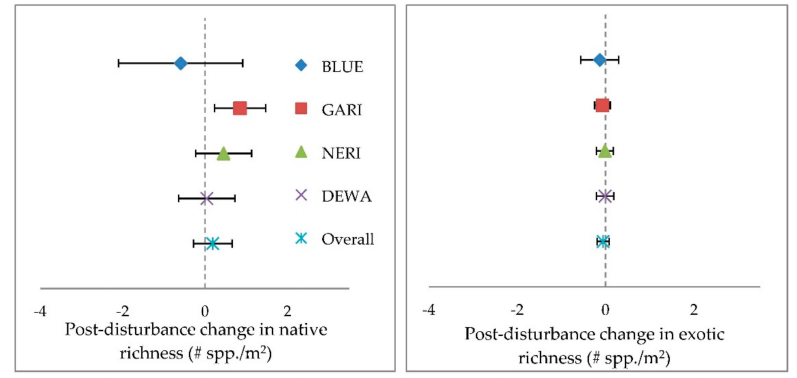
Figure 2. Tukey method comparison for differences of means (disturbed–undisturbed) in changes observed in average richness (number of species per m 2 ) for native ( left panel ) and exotic ( right panel ) plant species between disturbed and undisturbed plots for each NPS unit and for all the units combined following the disturbance events. Error bars represent +/ − one standard error of the difference. Asterisks represent a p -value of <0.05. Tables A2 and A3 contains a list of the means and sample sizes. Appendix A and Table A6 contain the values for the differences of means, standard error, and p -values. The y -axis (dashed line) meets the x -axis (solid line) at zero. Pre- and post-disturbance means as well as standard errors can be found in Table